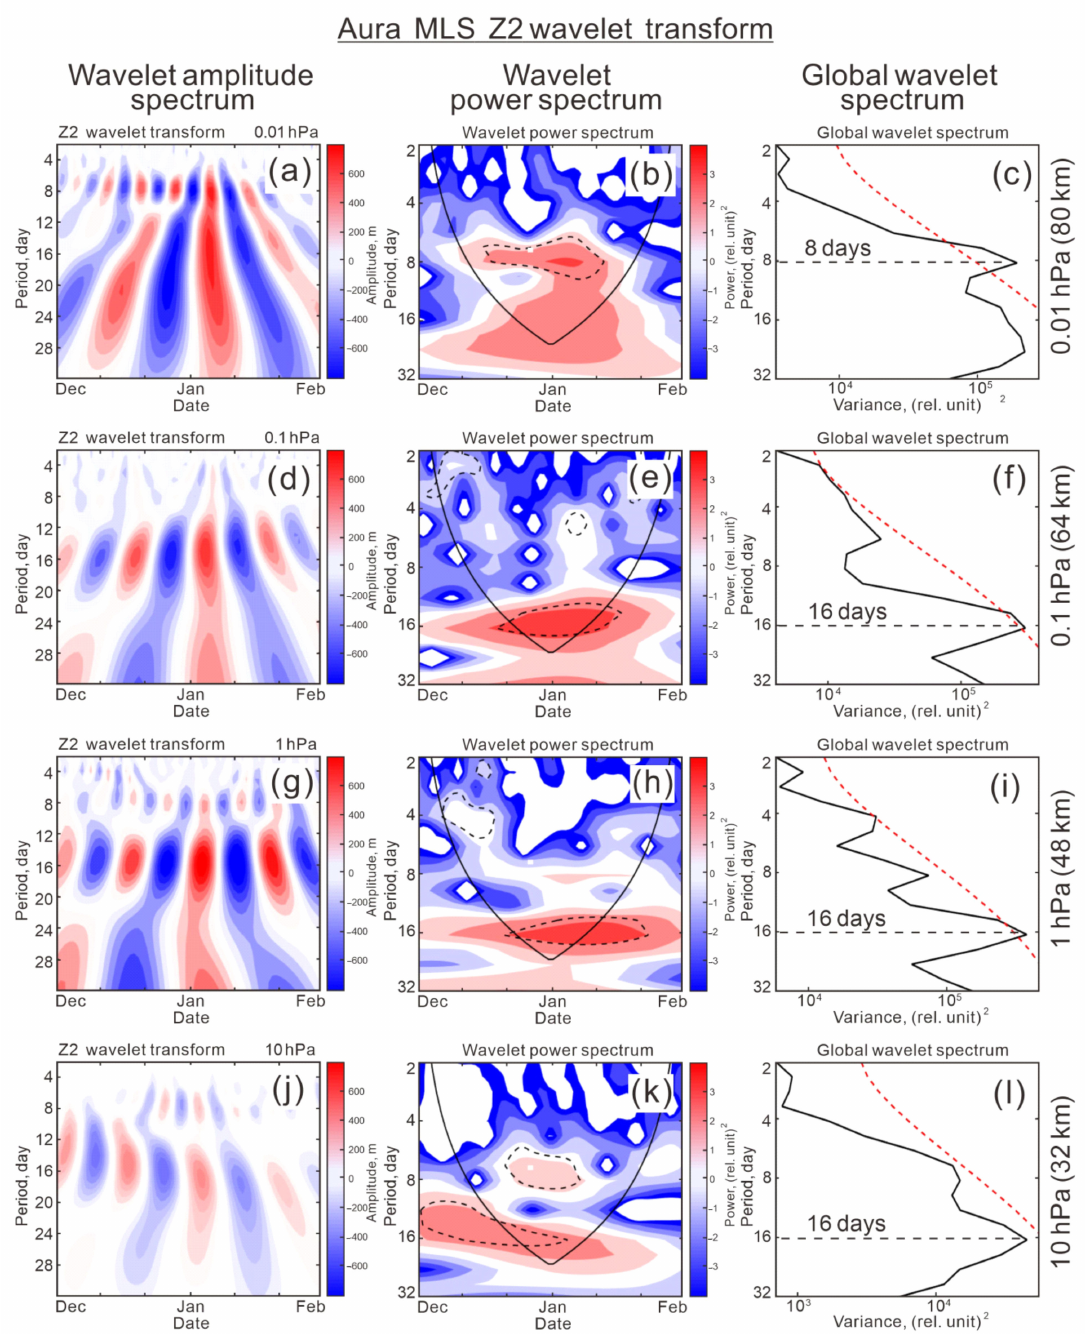
Figure 10. Wavelet transforms of time series of wave-2 amplitude, Z2, for ( a–c ) 0.01, ( d–f ) 0.1, ( g–i ) 1, and ( j–l ) 10 hPa. (left) Wavelet amplitude periods, (middle) wavelet power spectrum, and (right) global wavelet spectrum. Dashed contour in power spectrum and dashed line in global wavelet spectrum indicate 95% confidence